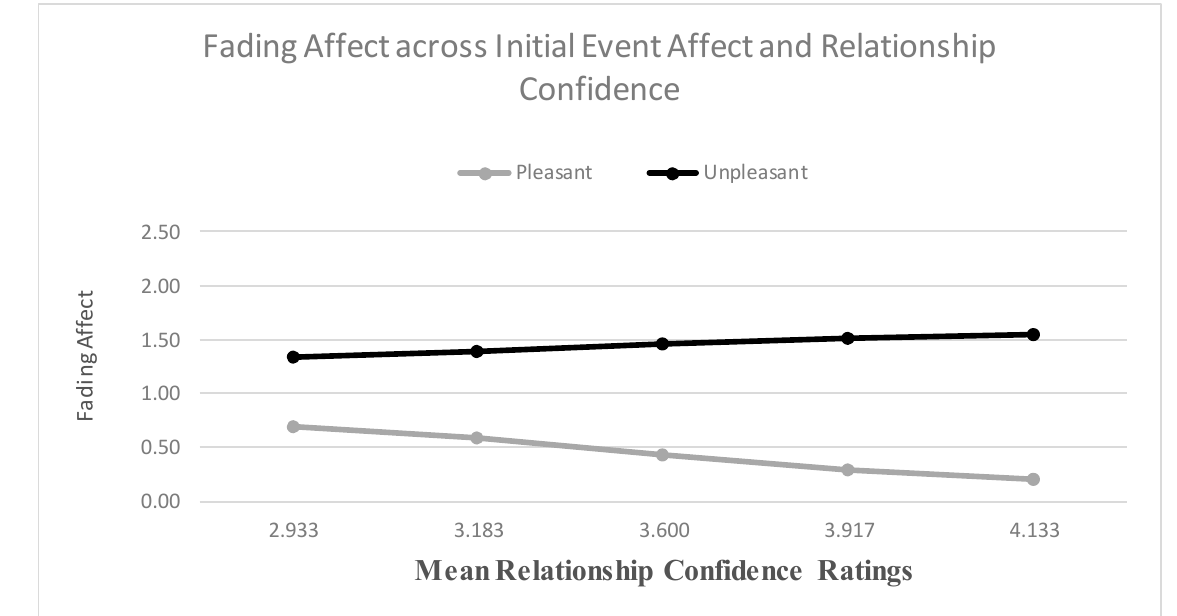
Figure 6. Fading affect for pleasant and unpleasant events across quintile levels (10th through 90th) of relationship confidence.